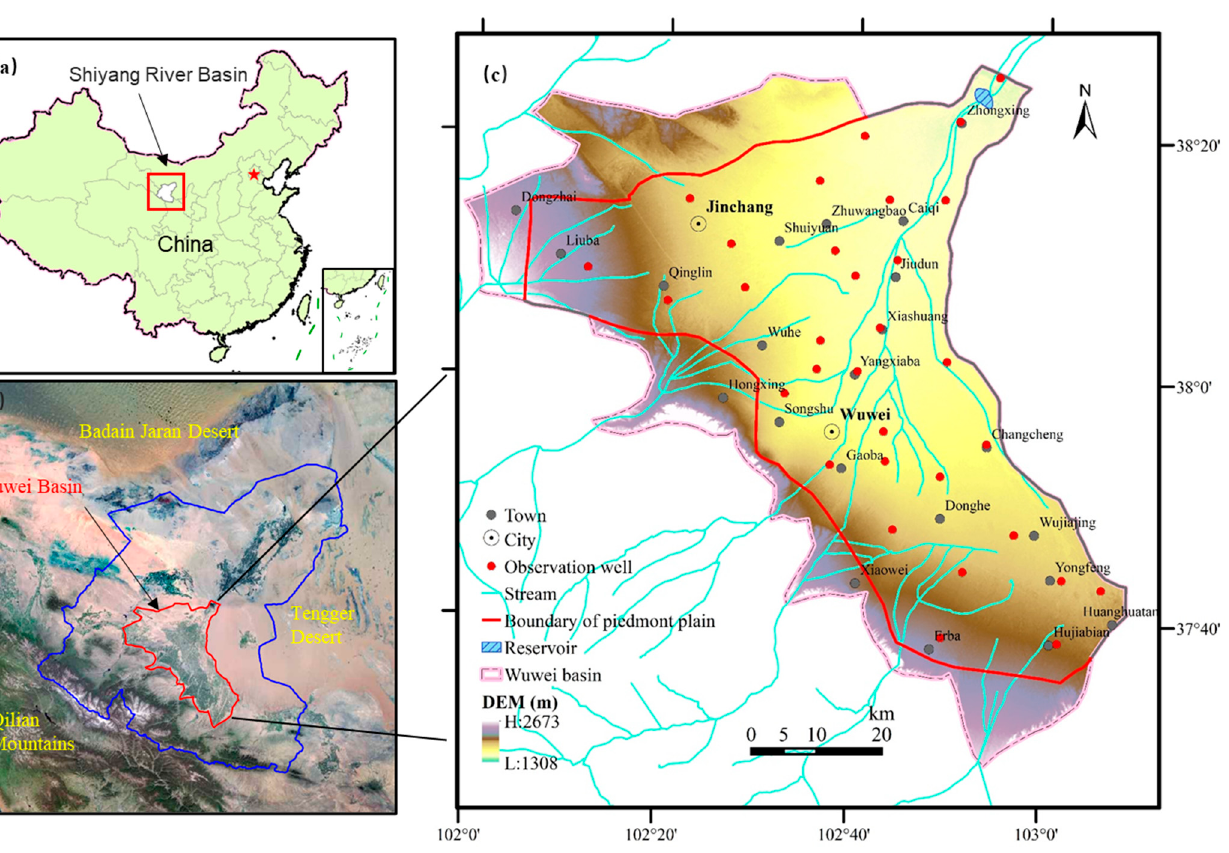
Figure 1. Location of ( a ) the Shiyang River Basin, ( b ) the Wuwei sub-basin, against the Shiyang River basin, ( c ) elevation distribution of the Wuwei sub-basin.